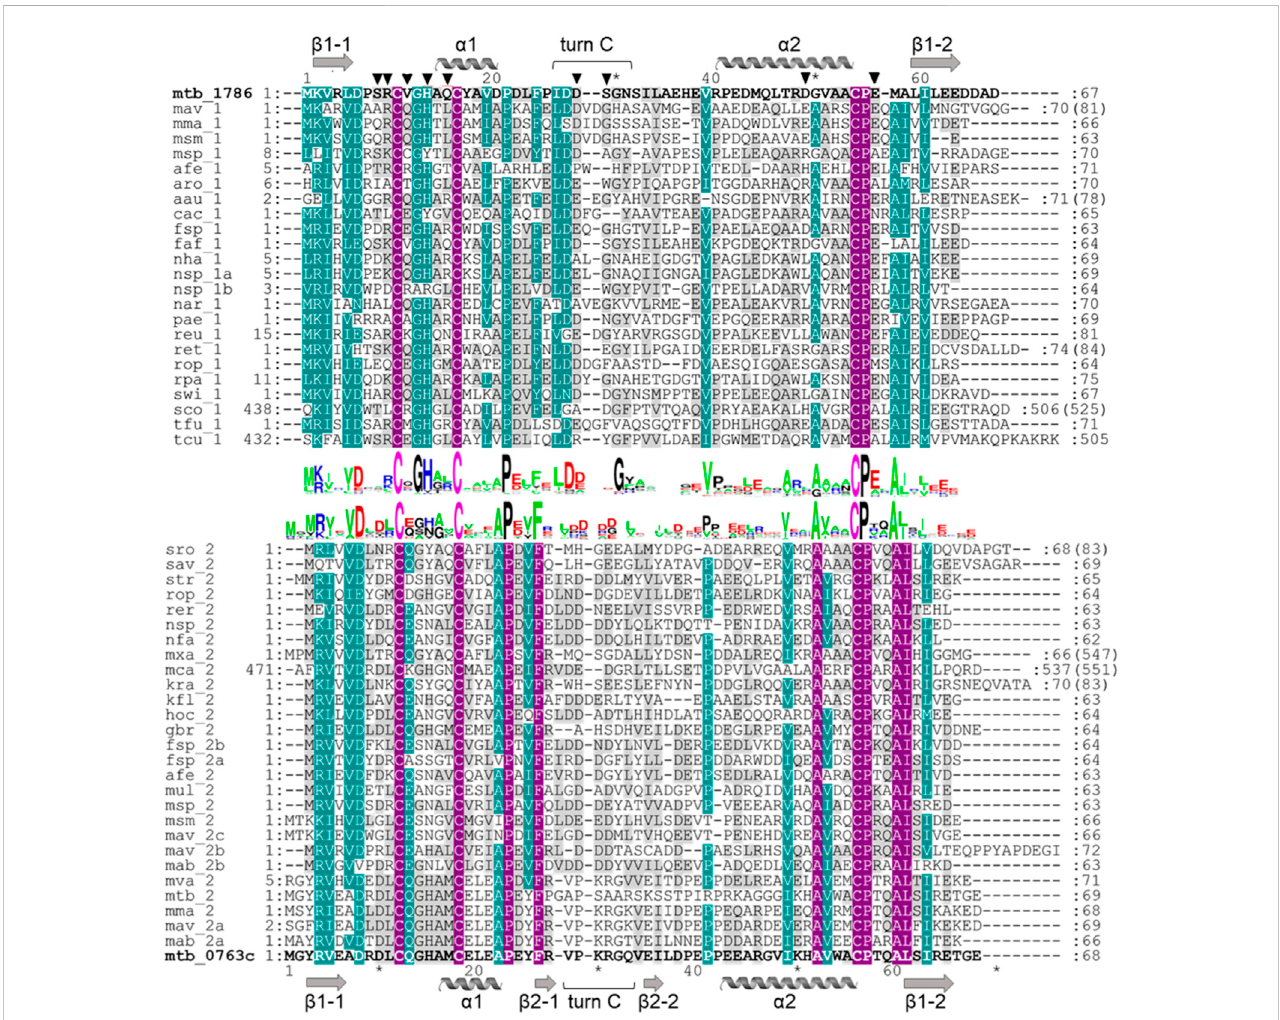
Multiple sequence alignment of ferredoxins taken from the genome context of Rv1786 (mtb_1786, NP_216302.1) and Rv0763c (mtb_0763c, WP_ 003403890.1) of Mtb (Supplementary Figure S3). Description for abbreviation of proteins is given in Supplementary Figure S2. Alignment was prepared using ClustalW algorithm. Sequence logos were prepared using WebLogo (https://weblogo.berkeley.edu/). Violet color indicates identical residues, turquoise color — residues with 75% of homology, and gray color — residues with 35% of homology. Numbers at the beginning and end of each row correspond to the fi rst and the last amino acids of each sequence taken for alignment, respectively. Numbers in brackets indicate the total number of amino acids in the corresponding proteins. Amino acids important for the interaction with redox partner are shown as triangles.